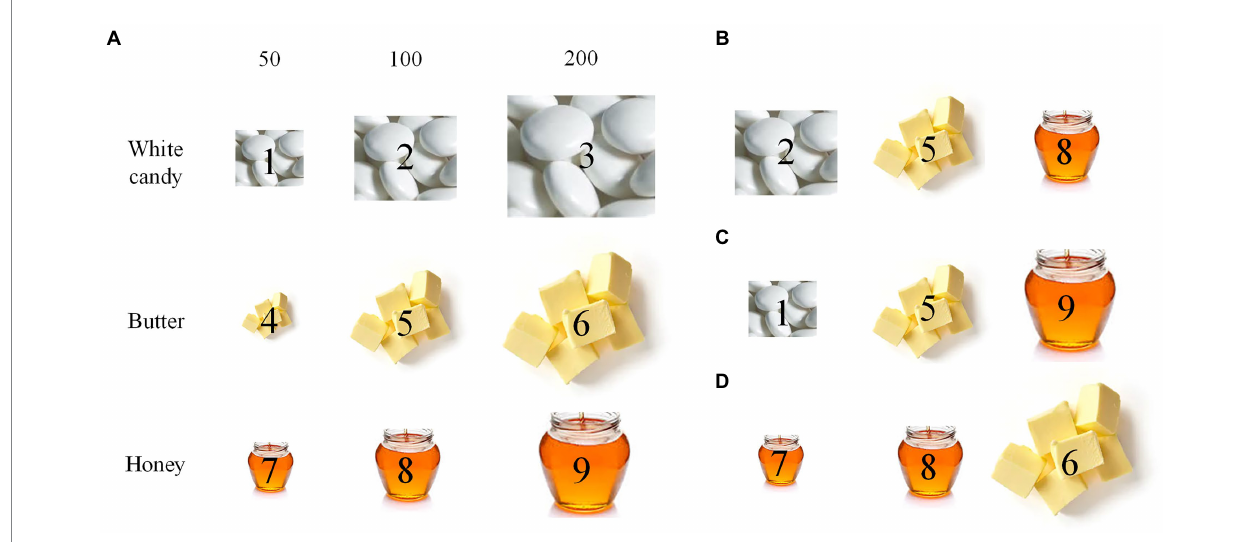
FIGURE 3 Example answers of the fair test 2. (A) Nine piles of ingredients for selection: 50, 100, and 200 are milligrams, and each pile is marked by an index of 1–9. (B) A choice of three piles, denoted by 2–5–8, matching the fair test requirement. (C) A choice of three piles, 1–5–9, partially matching the